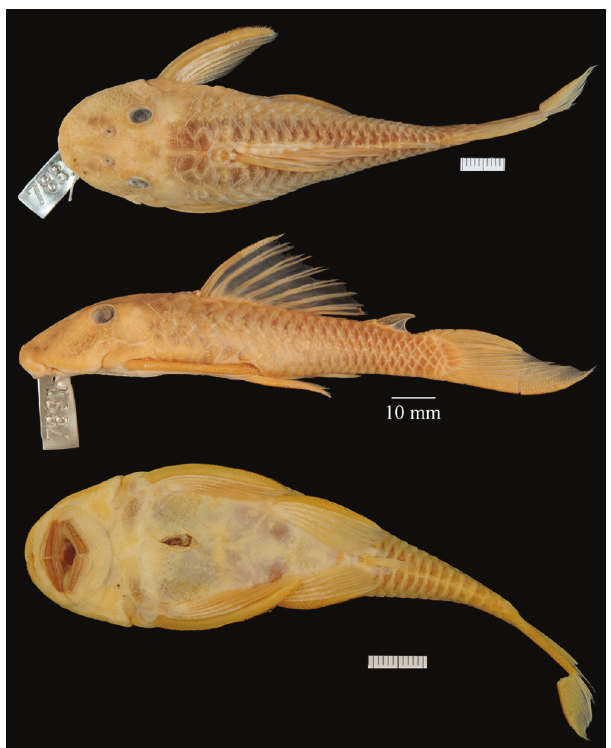
Fig. 1. Hypostomus johnii , lectotype, MCZ 7831, 94.0 mm SL, Brazil, state of Piauí, municipality of Teresina, rio Poti, tributary of rio Parnaíba. Dorsal, lateral and ventral